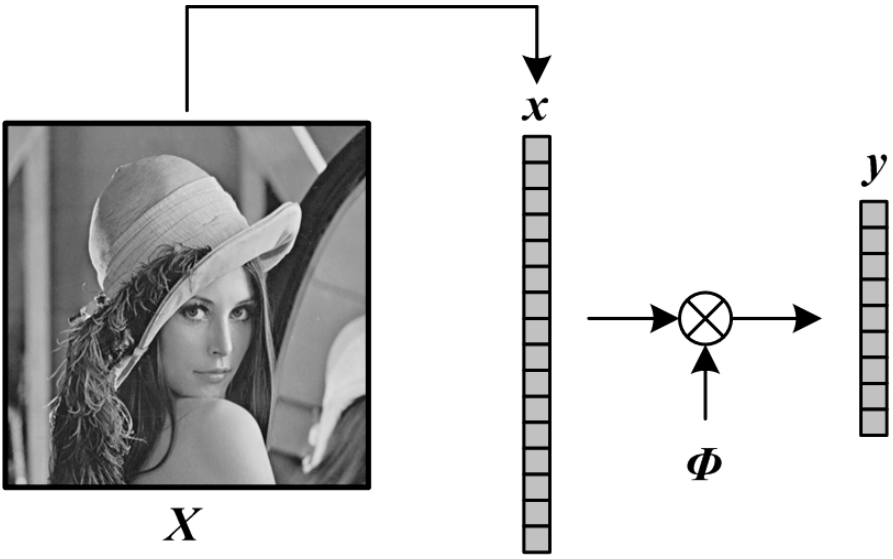
Figure 1. Illustration on WH format.